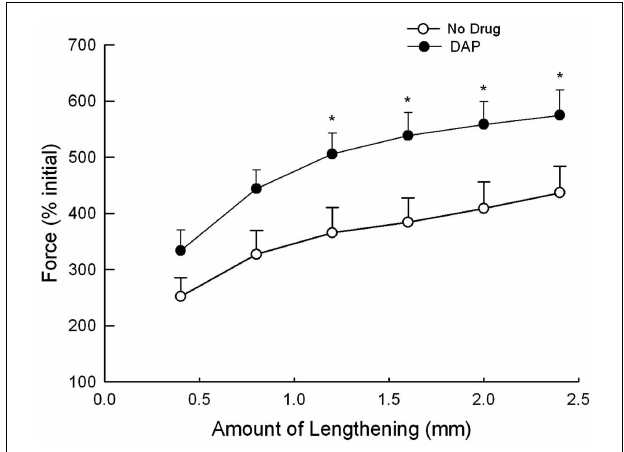
FIGURE 6 | Force during 30Hz eccentric contraction at different lengths at a velocity of 2–12mm/s with and without DAP. Data are expressed as a percent of the initial pre-drug isometric twitch force.Values are means ± SE.